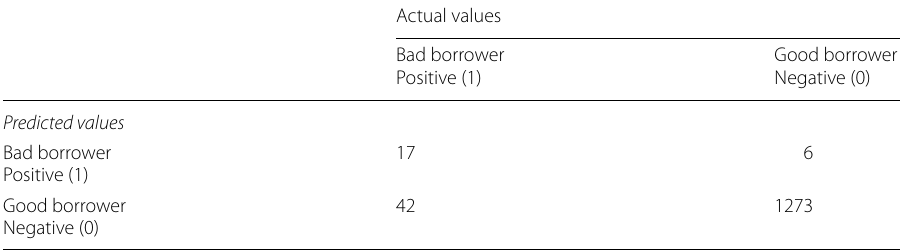
Table 7 Confusion matrix—self-supervision approach